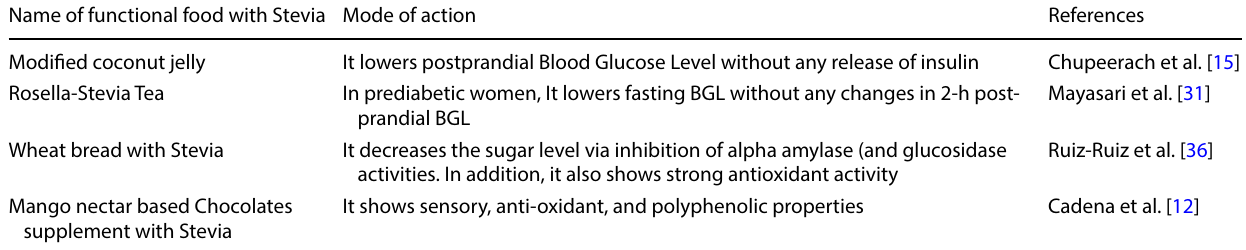
Table 1 The uses of Stevia as functional food for the treatment of diabetes disease Name of functional food with Stevia Mode of